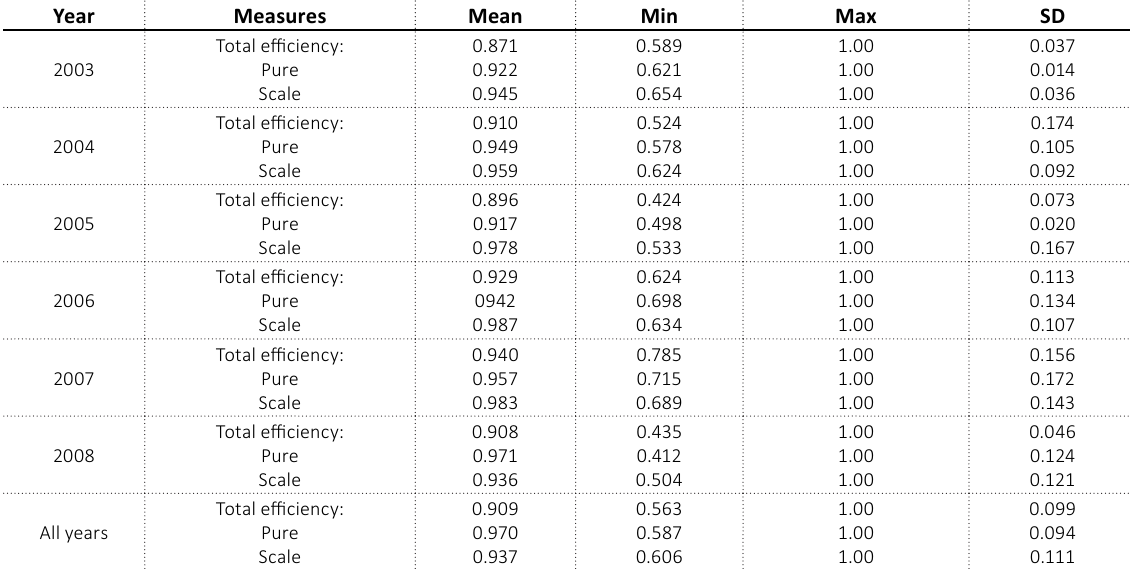
Table 3. Measures of efficiency of all banks before the crisis